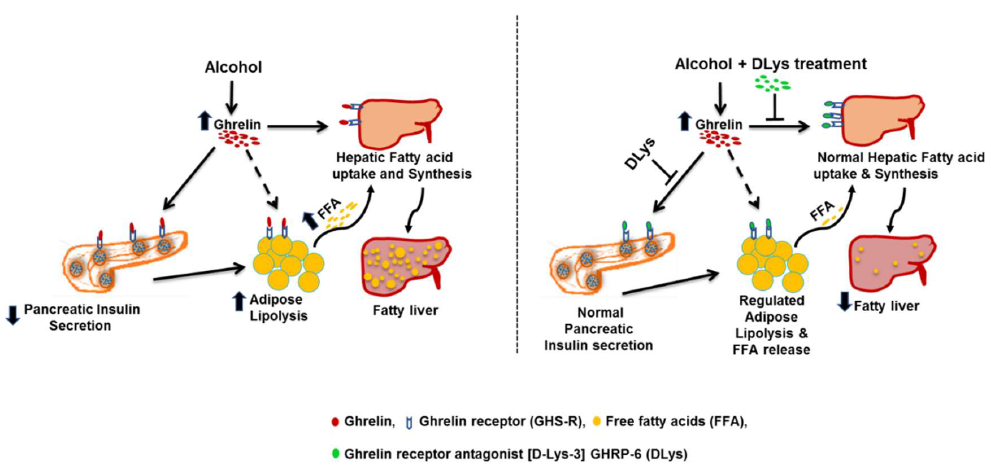
Figure 7. Mechanistic role of ghrelin receptor antagonist in attenuating alcohol-induced hepatic steatosis. Alcohol elevates levels of circulating ghrelin which binds to its receptor, GHS-R, on pancreatic β-cells to impair insulin secretion. The consequent reduction in the circulating insulin levels contribute to increased free fatty acid mobilization from adipose tissue to the liver. Ghrelin also directly act on liver via the ghrelin receptors that are present on hepatocytes, to promote circulating free fatty acid uptake, increase de novo fatty acid synthesis and inhibit fatty acid oxidation, thereby contributing to the development of hepatic steatosis. Inhibition of ghrelin activity by receptor antagonist. [ D -Lys-3] GHRP-6 (DLys)-attenuated alcoholic steatosis by improving pancreatic insulin secretion, normalizing serum insulin levels, inhibiting adipose lipolysis, decreasing circulating free fatty acid levels, and preventing de novo fatty acid synthesis in the liver.